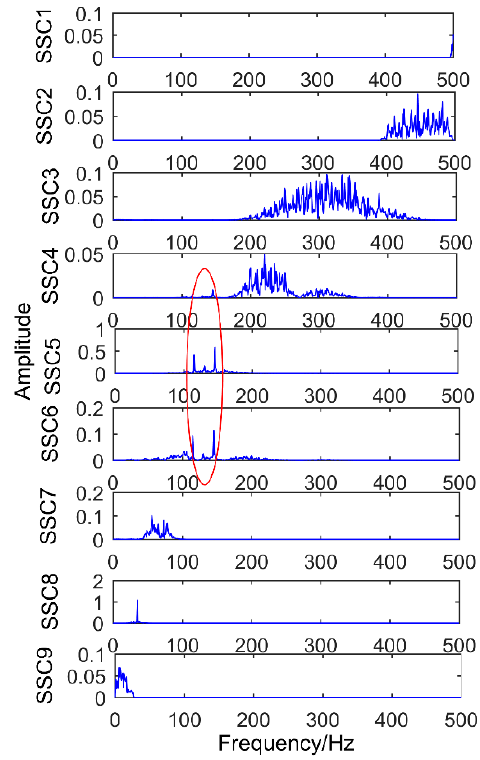
Figure 18. Frequency domain diagram of the decomposition results obtained by SSD.